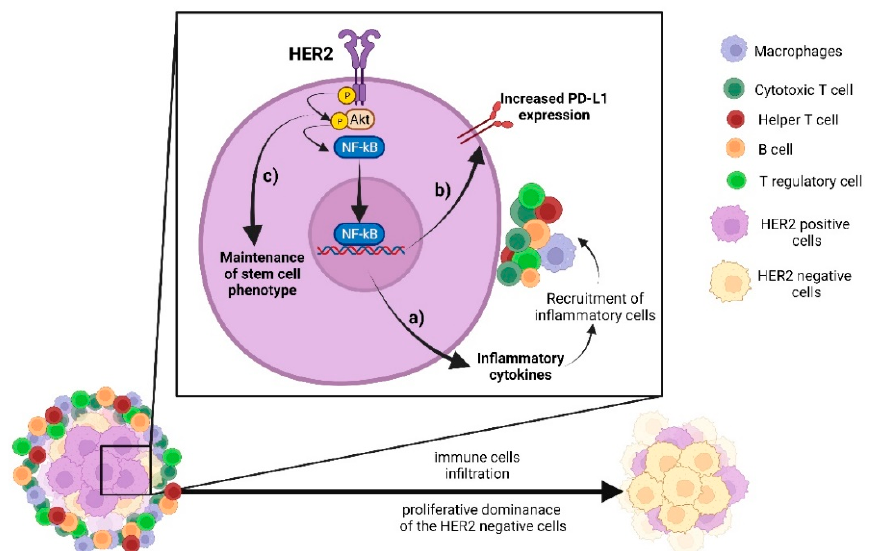
Figure 1. Crosstalk between HER2 pathway and immune signalling. HER2 signalling activates the AKT → NF- κ B axis, which stimulates: ( a ) production of inflammatory cytokines and infiltration of immune cells; ( b ) increase of PD-L1 expression; and ( c ) maintenance of stem cell phenotype. All those phenomena may also confer proliferative dominance of HER2-negative cells, leading to HER2-negative invasive recurrence/progression.